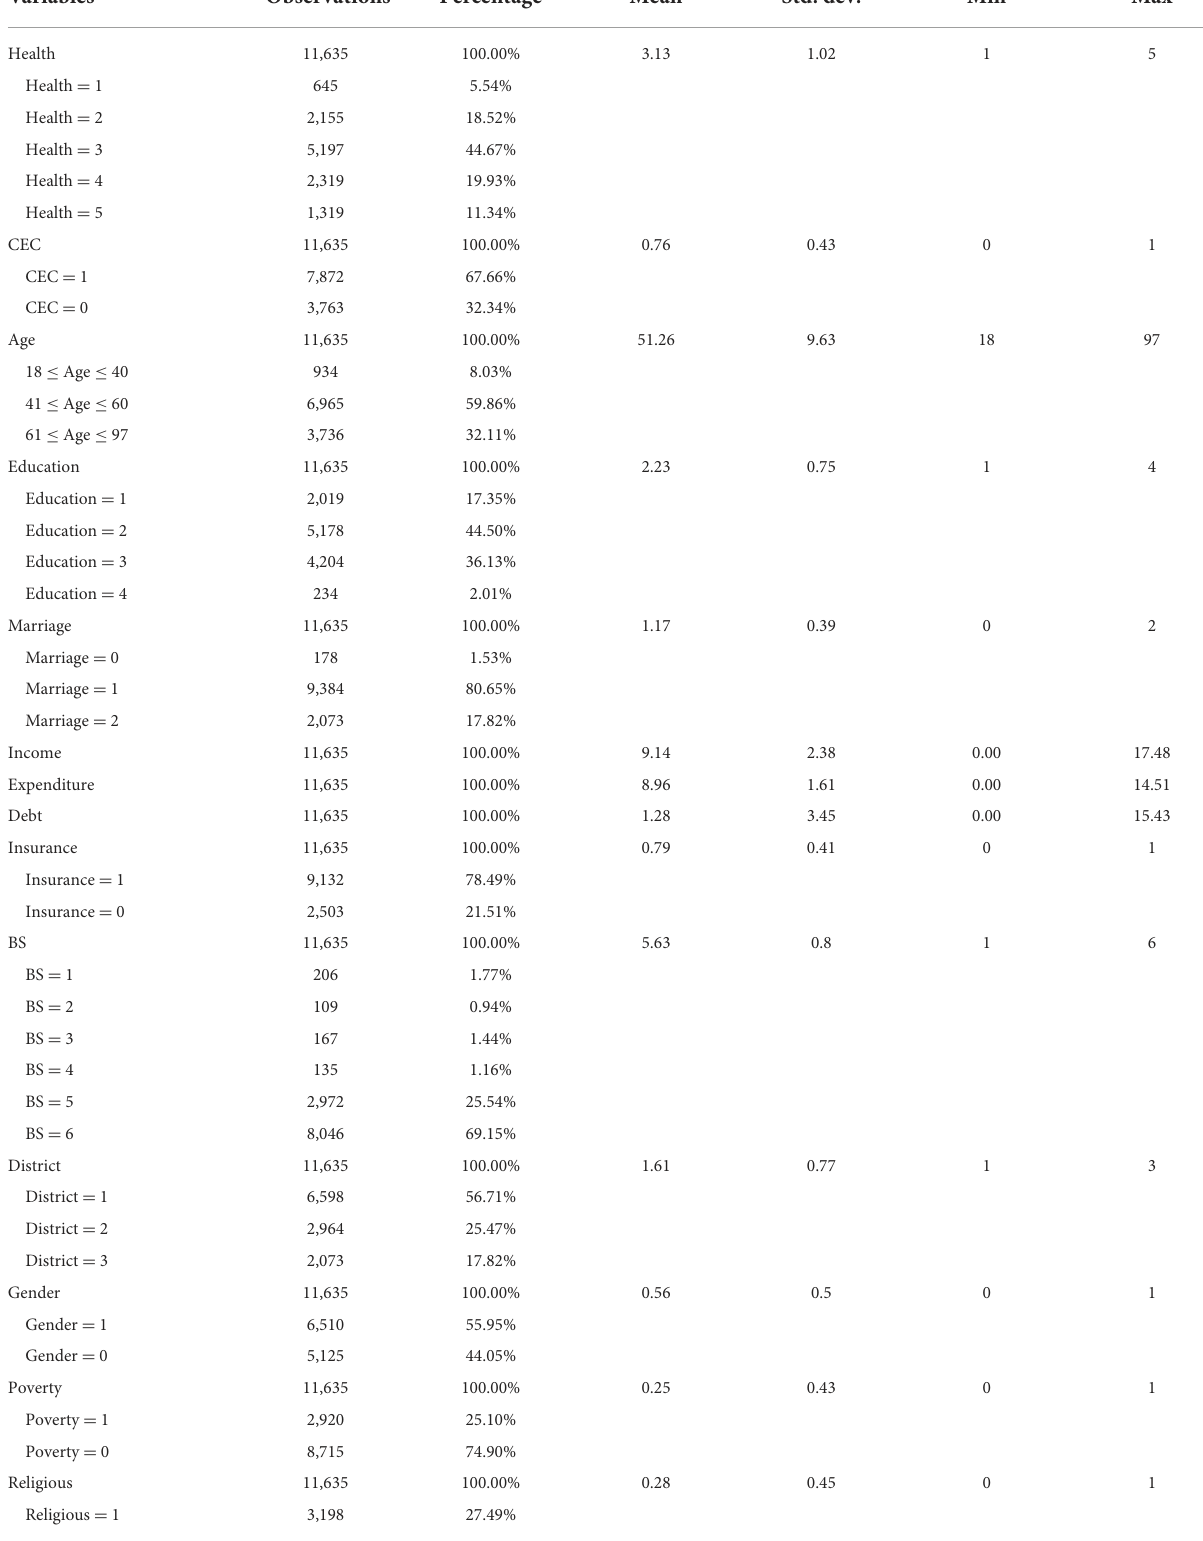
TABLE 2 Descriptive statistics of the studied